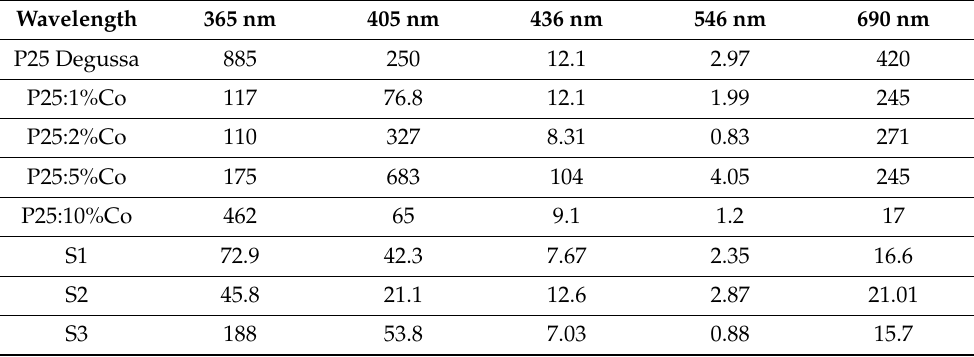
Table 5. Photocatalytic constant k of the studied samples normalized to the integral intensity of the spectral peaks for different wavelength emitted by mercury lamp. In the Table are represented values of k × 10 7